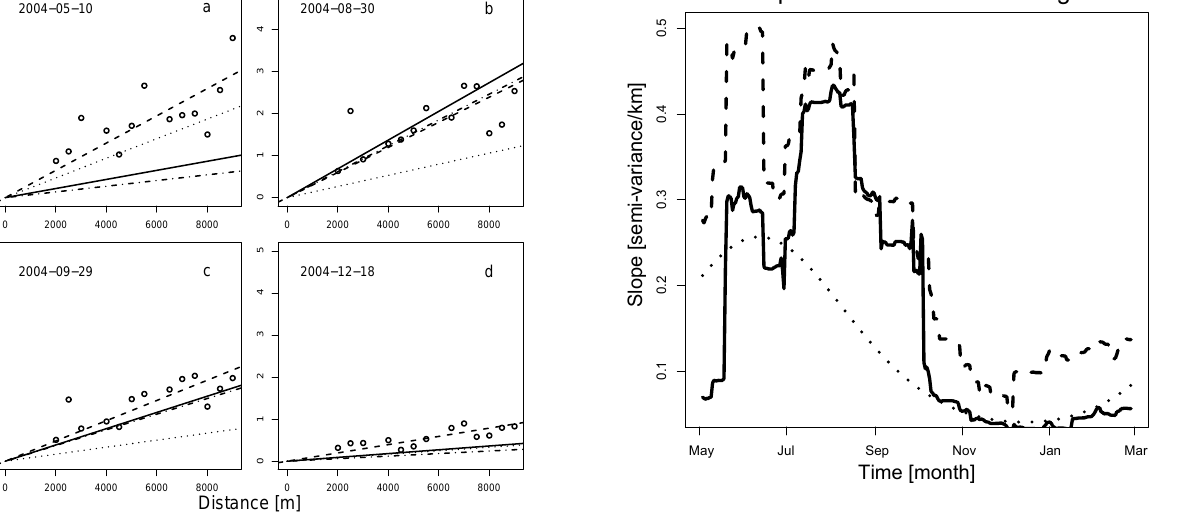
Fig. 13. Slope of the first 10km of the variogram for the period between March 2004 and March 2005. The dashed line is the actual fit, the solid line is the fit found in Sect. 5.2.4 from the combined KNMI and UU-WUR rain gauge data and the dotted line the clima- tological